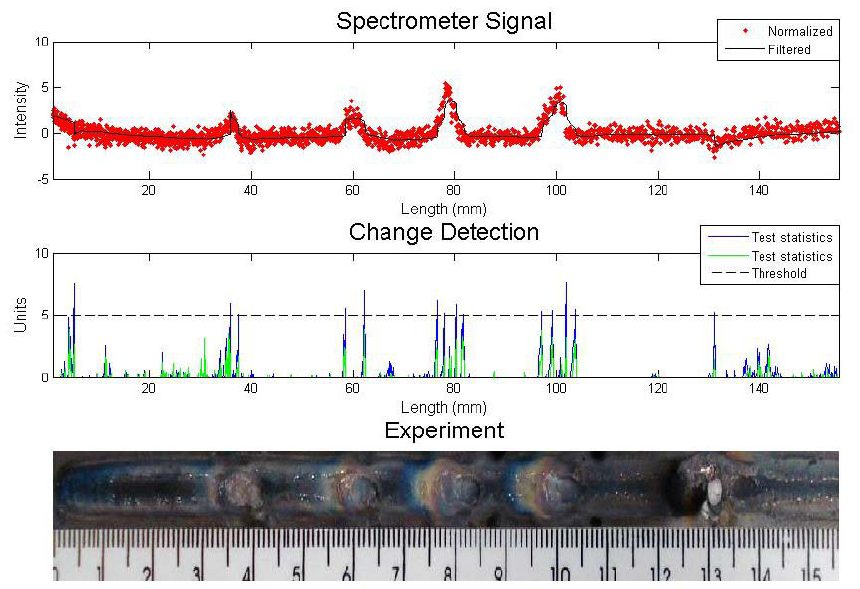
Figure 5. Experiment with metallic and sand inclusions – analysis with proposed